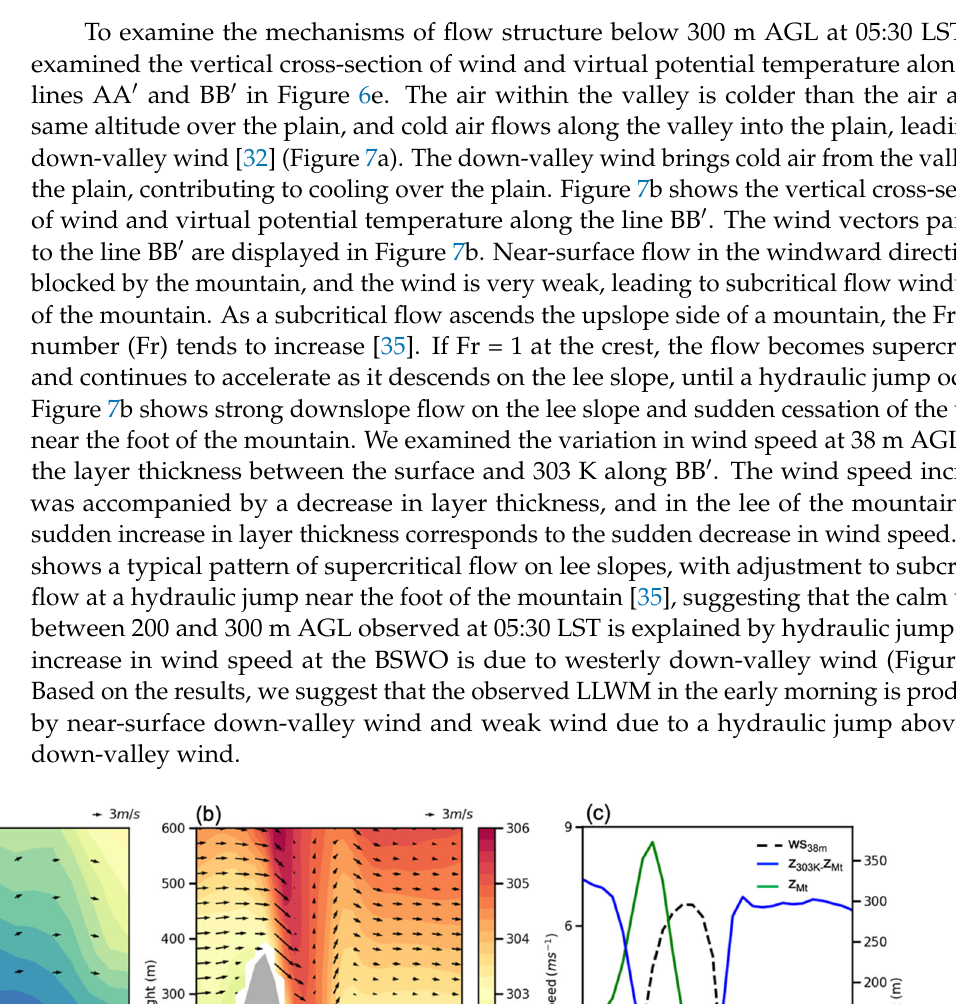
Figure 6. Horizontal distribution of horizontal wind and pressure (hPa) at 1800 m AGL for D02 ( a , b ), at 300 m AGL for D03 ( c , d ) at 05:30 ( a , c ) and 14:30 LST ( b , d ), and horizontal distribution of 10-m wind vectors with topography (m) in the analysis domain at ( e ) 05:30 LST and ( f ) 14:30 LST. A red dot indicates the location of the BSWO. White color in ( c,d ) in- dicates high-elevation areas with terrain height of more than 300 m AGL.